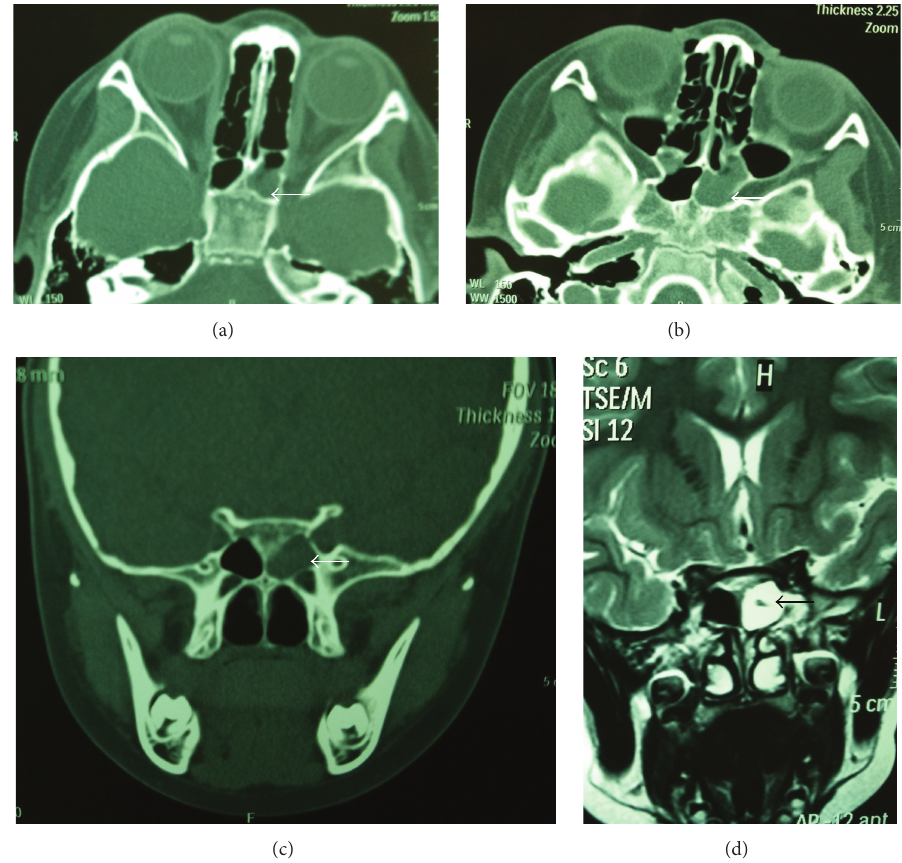
Figure 1: (a and b) Axial CT scans showing only sphenoid sinus with soft tissue density shadows on the left ( white arrow ). (c) Coronal CT scans of a patient with soft tissue density shadows in the left sphenoid sinus ( white arrow ). (d) T2-weighted MRI shows hyperintensity in the left sphenoid sinus ( black arrow